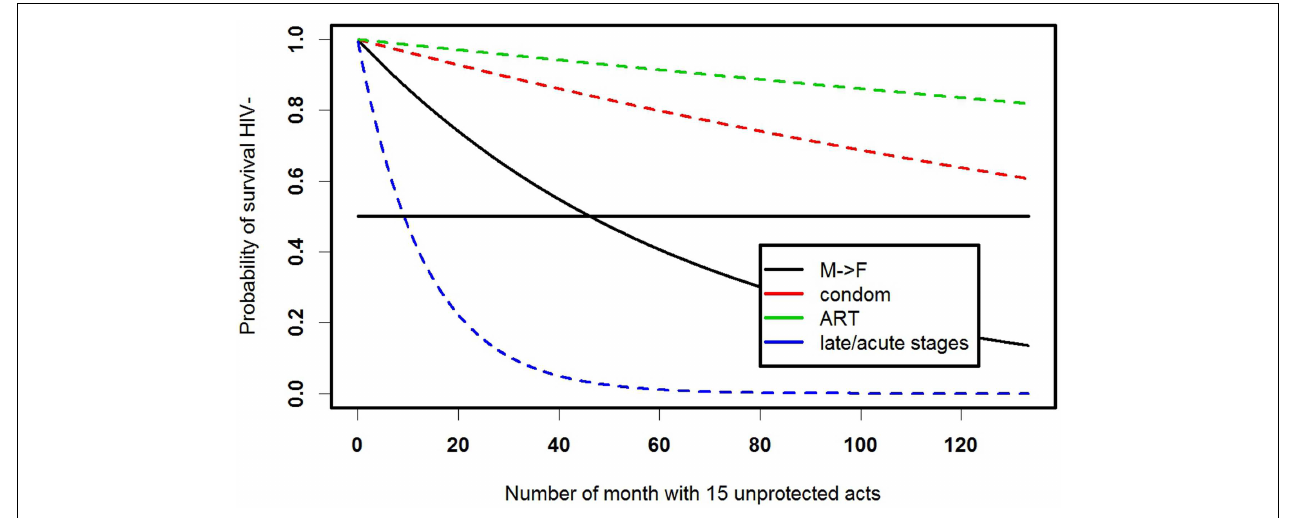
FIGURE 3 | Survival curves for staying HIV negative for a female with a male HIV-positive partner in a latent HIV stage, assuming two unprotected vaginal intercourses per week . Model details and parameters are described in detail in Ref.